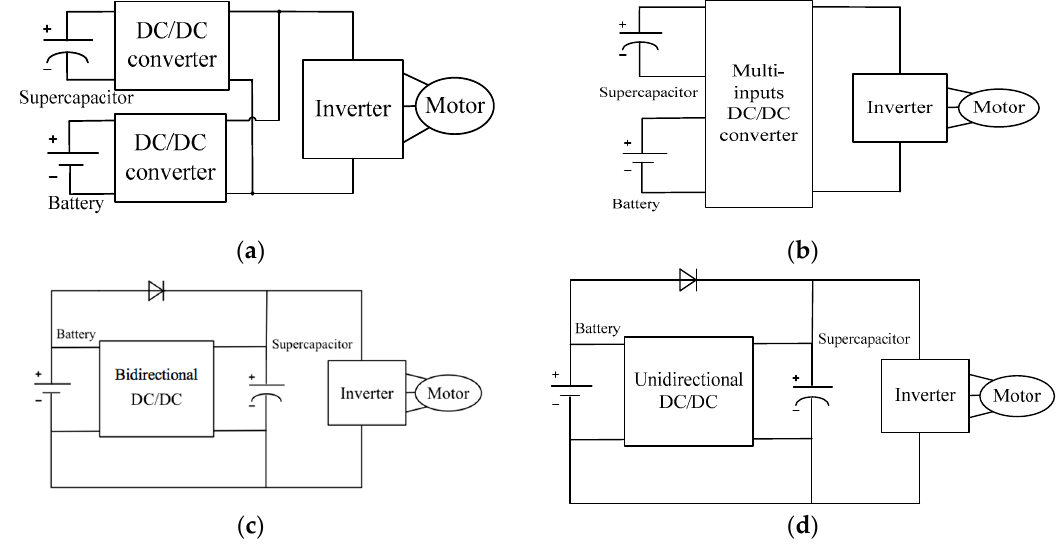
Figure 2. Different HESS topologies: ( a ) Fully active configuration; ( b ) multiple inputs DC/DC; ( c ) semi-active configuration incorporated (bidirectional); ( d ) semi-active configuration incorporated with a diode (unidirectional).